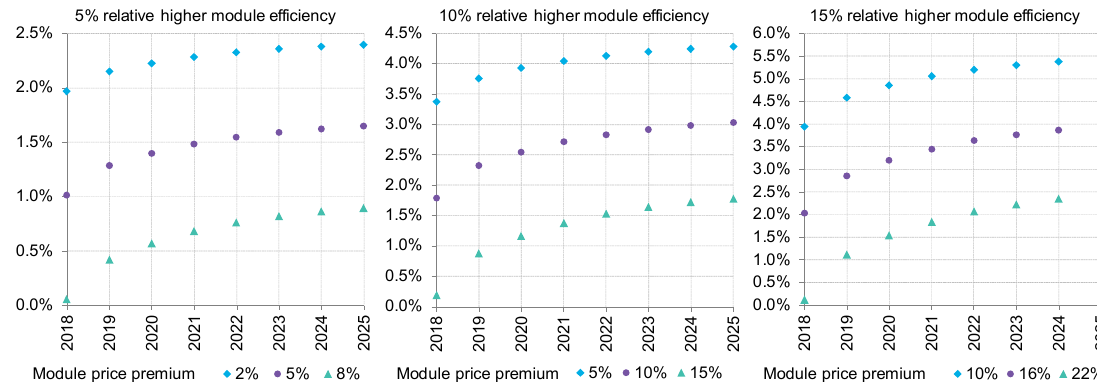
Figure 11. PV LCOE reduction vs. module efficiency and module price, 2018‒2025. Note: The module efficiency compared with the benchmark in a specific year. For instance, 5% relative higher module efficiency in 2018 points to a module efficiency at 17.7%*1.05, or 18.6%. 15% relative higher module efficiency in 2025 points to a module efficiency at (17.7%*1.025^7)*1.15, or 24.2%. In this paper, we